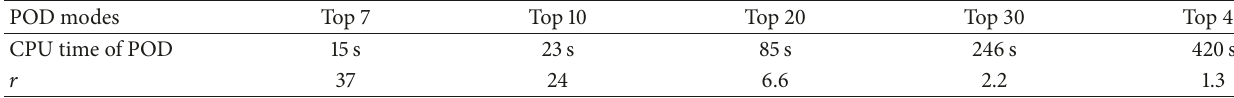
Table 3: Computational time using top 7 ∼ top 40 modes.